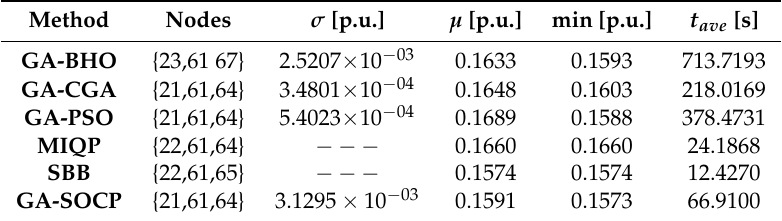
Table 4. Comparison of different approaches in the 69-node test feeder. Method Nodes σ [p.u.] µ [p.u.] min [p.u.] t ave